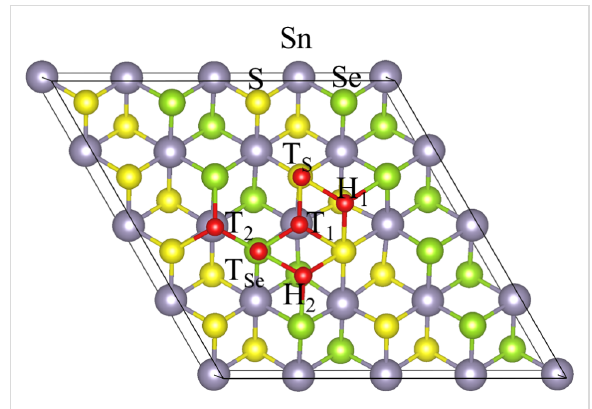
Figure 2: Atom configuration of possible adsorption sites for hydrogen on the SnSeS monolayer.